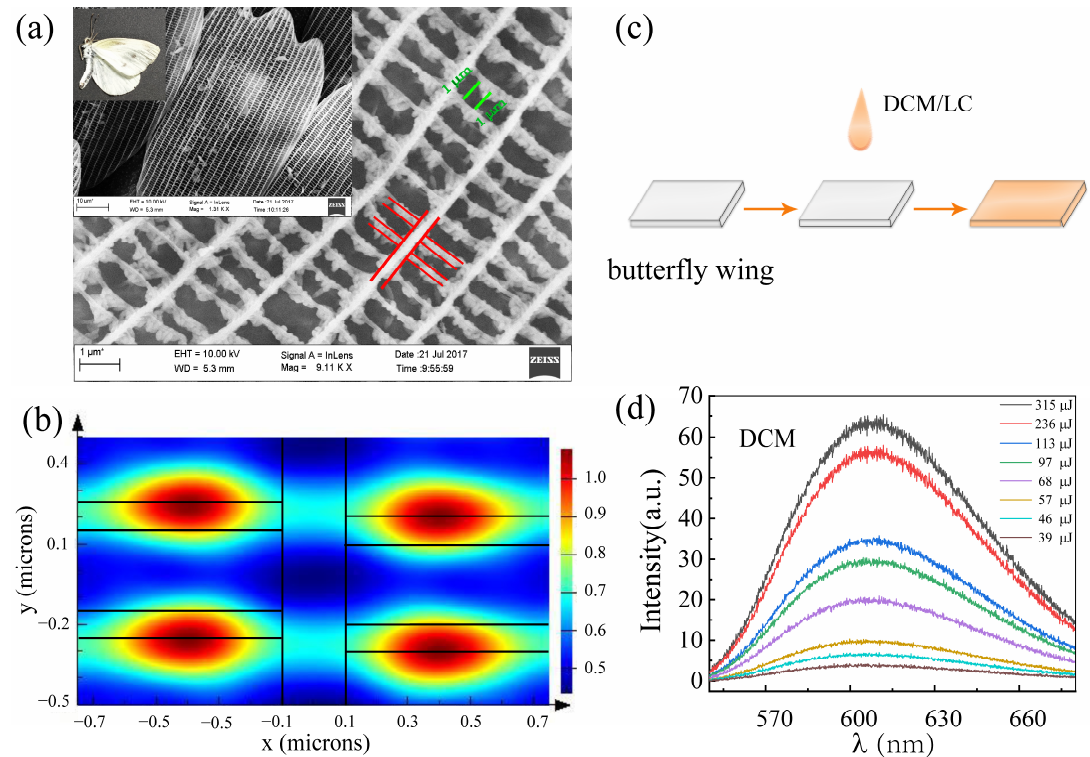
Figure 1. ( a ) Panoramic image and SEM images of butterfly samples (Pieris rapae crucivora); ( b ) The light field distribution inside the structure of the butterfly when visible light is shone on its wings (the black lines in the figure correspond to the red lines marked in ( a )); ( c ) Preparation process of DCM/LC/Wing samples; ( d ) Fluorescence spectra of dye DCM at different pump energies. Table 1. The samples and their components used in the